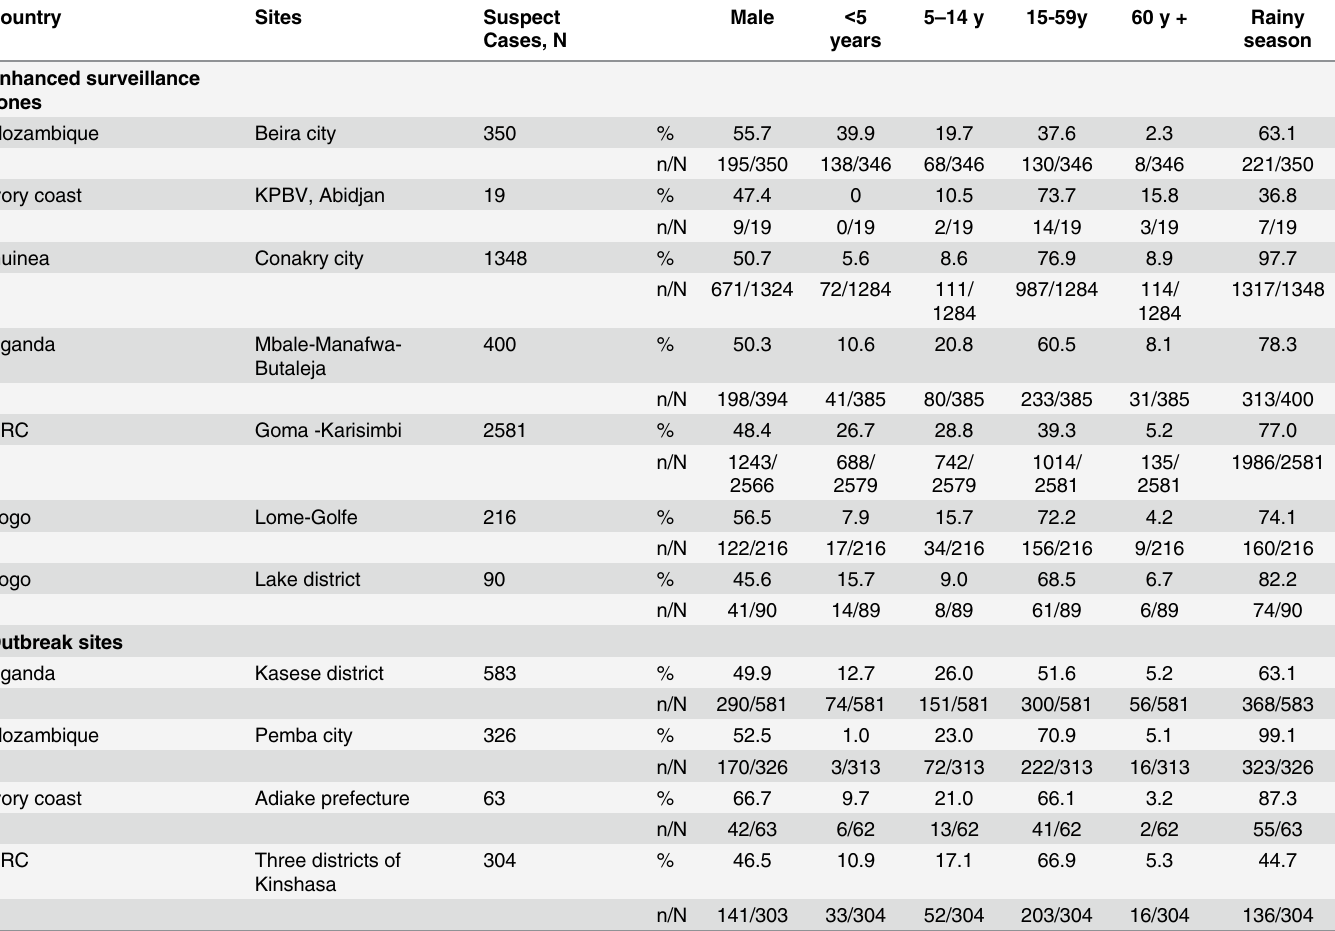
Table 2. Gender, age and season of occurrence of cholera suspect cases. N = 6280. Country Sites